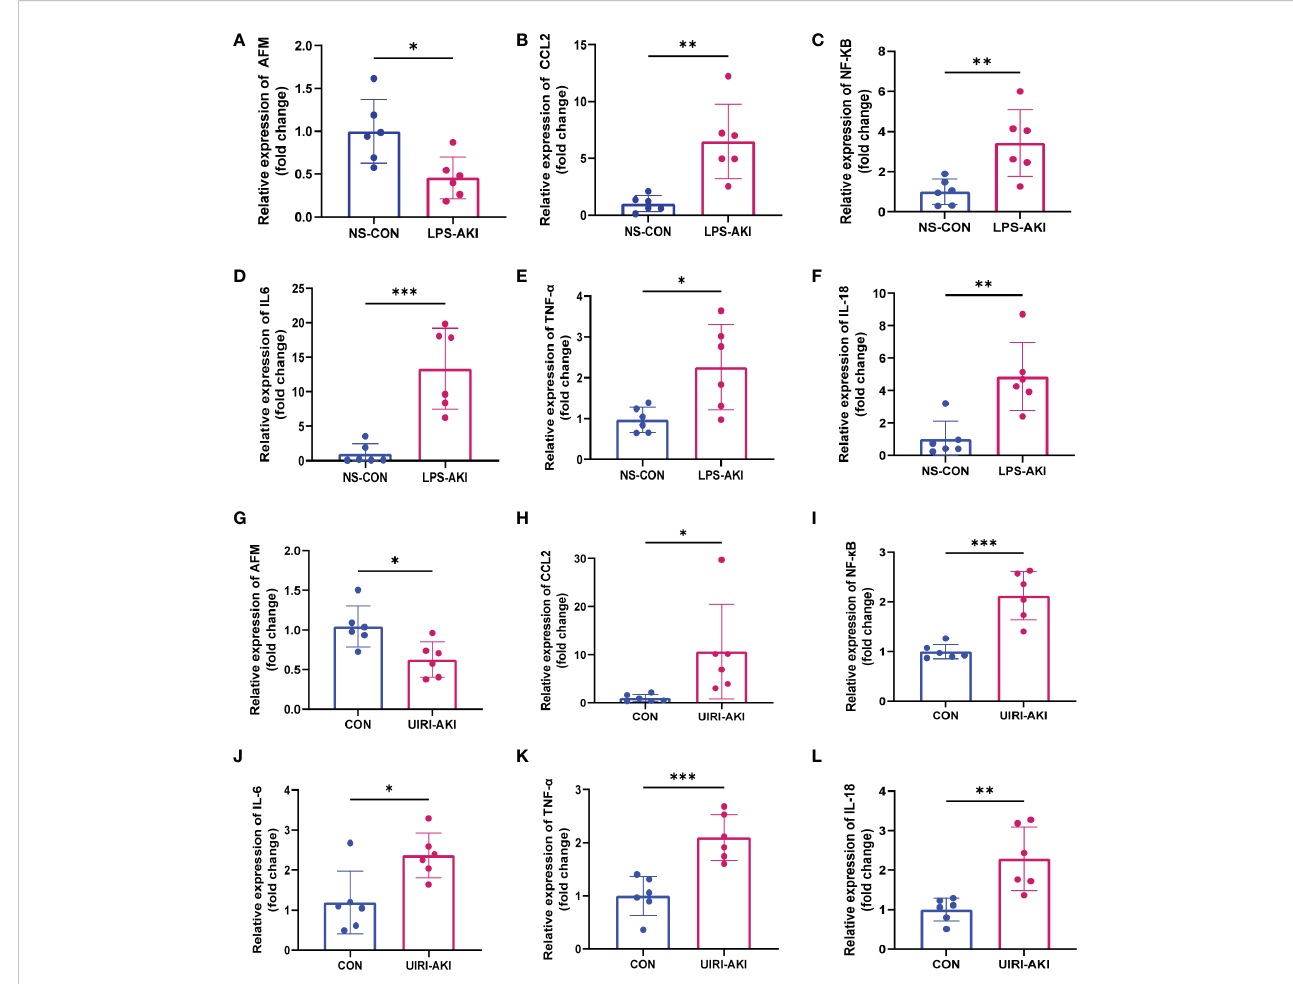
FIGURE 7 (A – F) Relative expression level of AFM, CCL2 and in fl ammatory indicators mRNA in LPS-AKI mice model. (G – L) Relative expression level of AFM, CCL2 and in fl ammatory indicators mRNA in UIRI-AKI mice model. *p < 0.05, **p < 0.01, ***p < 0.001.